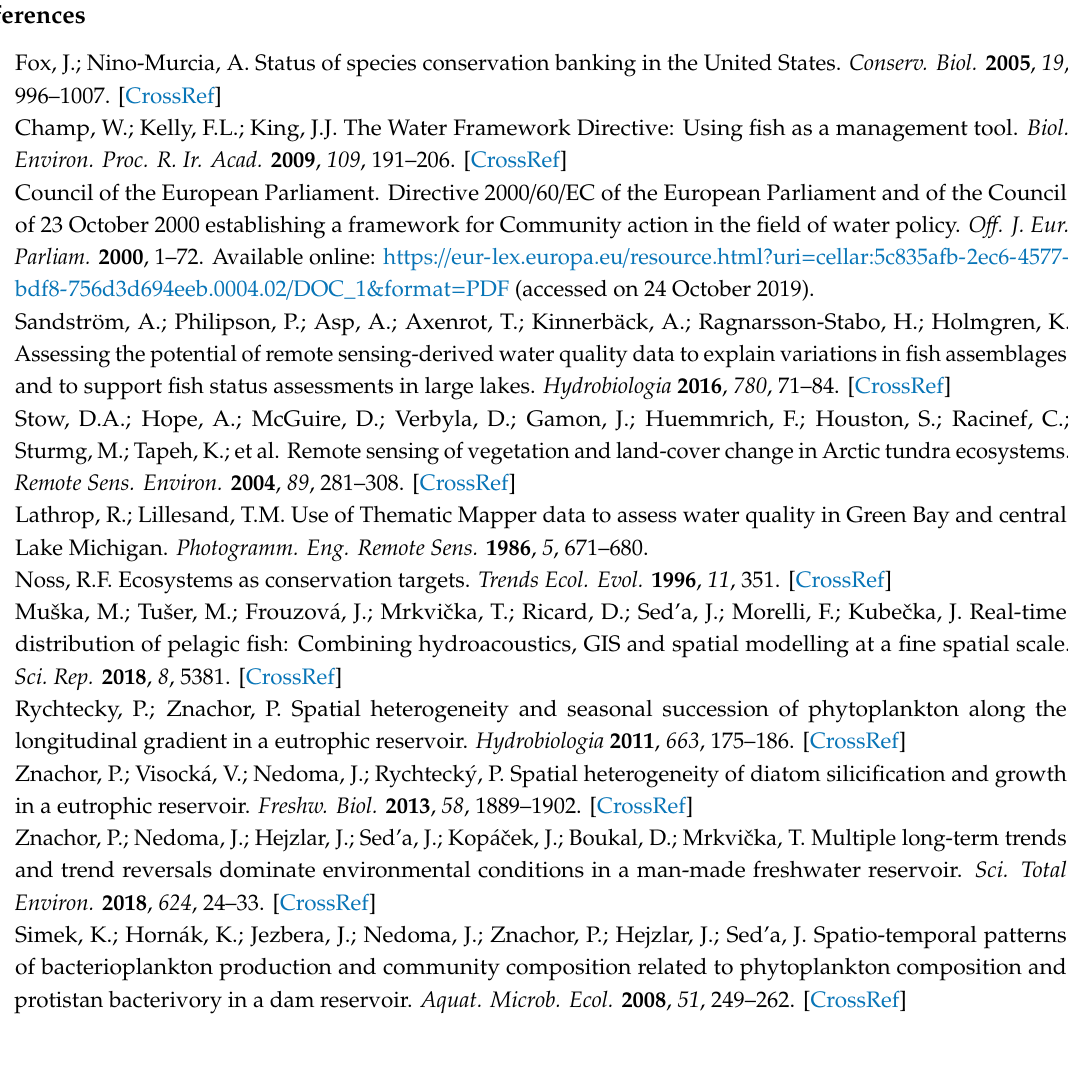
Figure S1: Landsat 5 water-quality parameters spatial distribution maps (for 17 August 2009), Figure S2: Landsat 8 water-quality parameters spatial distribution maps (for 23 August 2011), Table S1: Water-quality sampling dates with the most appropriate dates and satellite type of Landsat images used for the development of water-quality models, Table S2: Acoustic survey dates with the most appropriate dates and satellite type of Landsat images used for fish spatial distribution modeling and